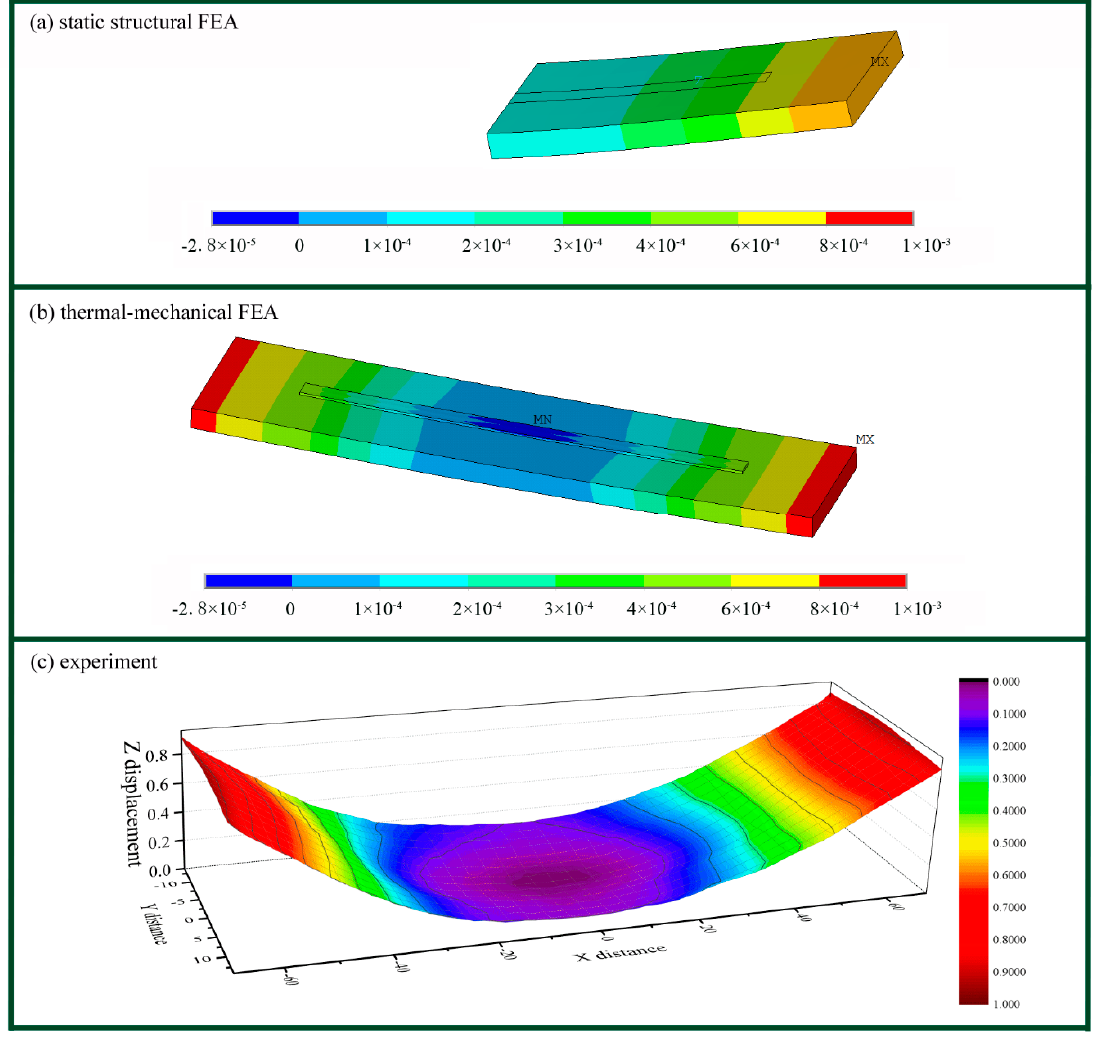
Figure 3. The distortion of the substrate as found by using the three methods. ( a ) The distortion of half of the substrate by as found by the static structural FEA when l d = 50 mm. ( b ) The distortion of the whole part as found by the thermal-mechanical FEA when l d = 50 mm. ( c ) The results of experimental distortion of the whole substrate when l d = 50 mm.